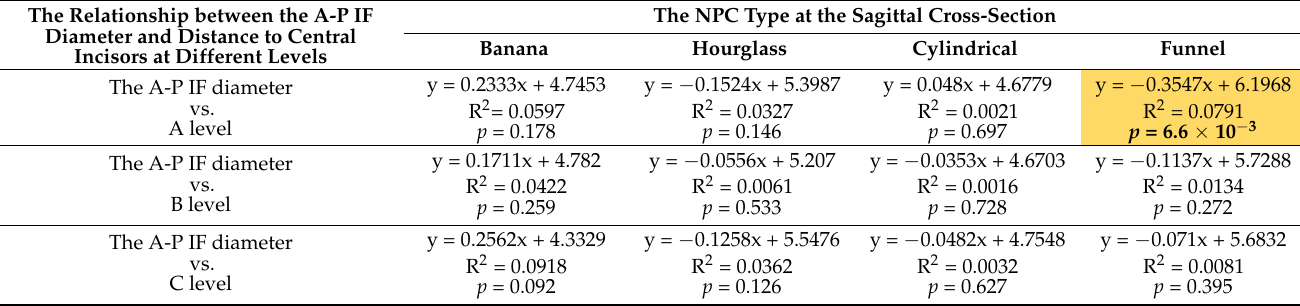
Table 5. Relationship between A-P NF diameter and distance to central incisors at different levels according to NPC type. The NPC Type at the Sagittal Cross-Section The Relationship between the A-P NF Diameter and Distance to Central Banana Hourglass Cylindrical Funnel Incisors at Different Levels The A-P NF diameter vs.